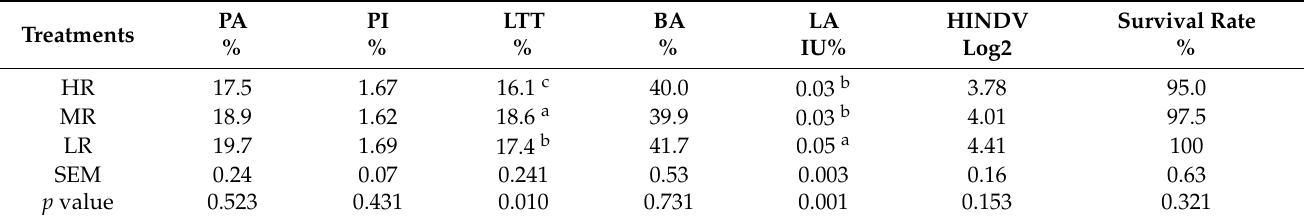
a–c : means within a column within each factor not sharing similar letters are significantly different p < 0.05. PA: phagocytic activity, PI: phagocytic index, LTT: lymphocyte transformation test, BA: bactericidal activity, LA: lysozyme activity, HINDV (Log 2 ): antibody titration against Newcastle disease virus (hemagglutination inhibition (HI)), IU: international unit. SEM: standard error of means HR: group fed diet with 16.7:1 ω -6/ ω -3 PUA; MR: group fed diet with 9.3:1 ω -6/ ω -3 PUFA; LR: group fed diet with 5.5:1 ω -6/ ω -3